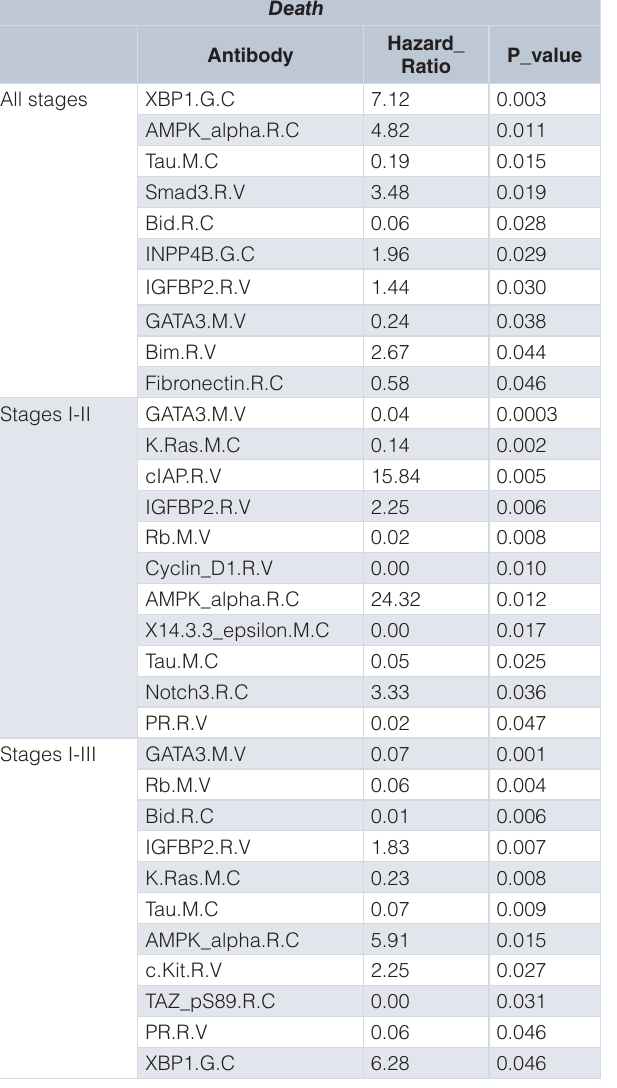
Supplemental Table 1. Hazard ratios and p-values for cox regression analysis identifying proteins associated with death. Only proteins with a significant p-value (<0.05) were included. Supplemental Table 2. Hazard ratios and p-values for cox